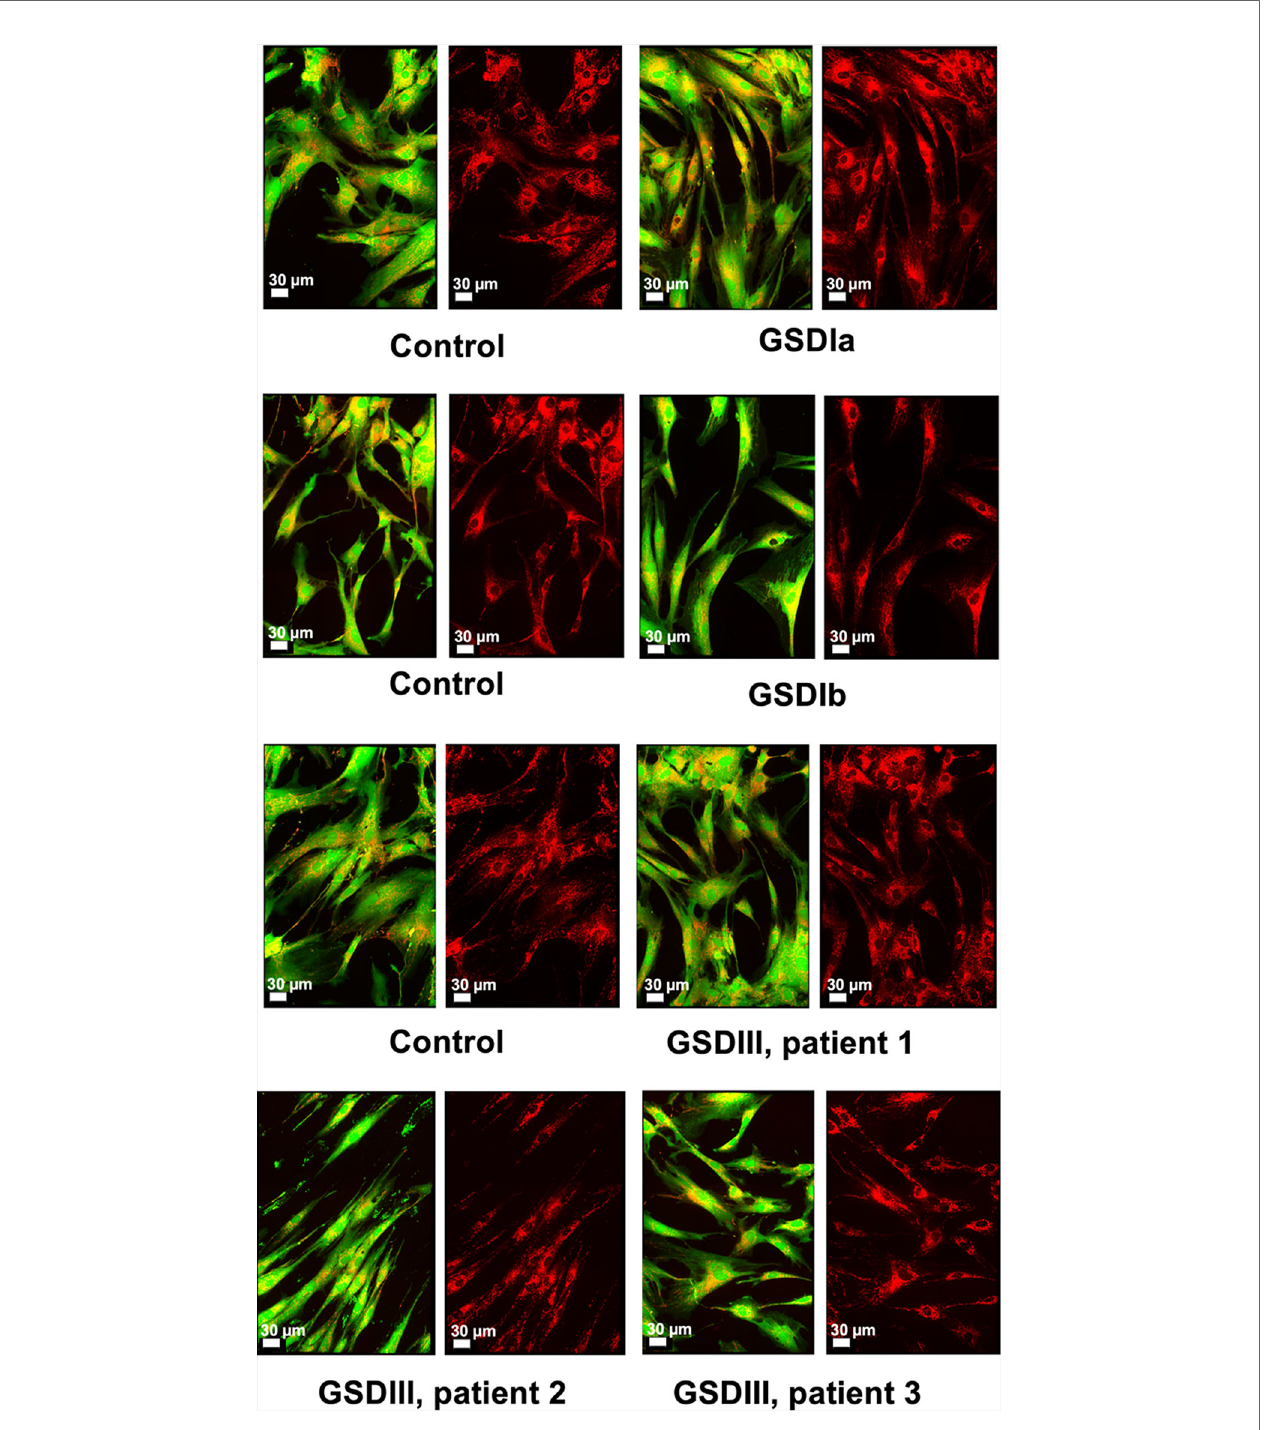
FIGURE 1 | Microscopy of live human skin fi broblasts from healthy controls and GSD patients. Spinning-disk live imaging of cells (green and red overlay) and their mitochondria (right panels, red). The images of three independent healthy controls and the different GSD subtypes revealed high similarity both in cellular morphology and mitochondrial distribution. Cell bodies were stained with Calcein ™ AM (Invitrogen) and mitochondria were stained with MitoViewTM 650 (Biotium). Scale shows 30